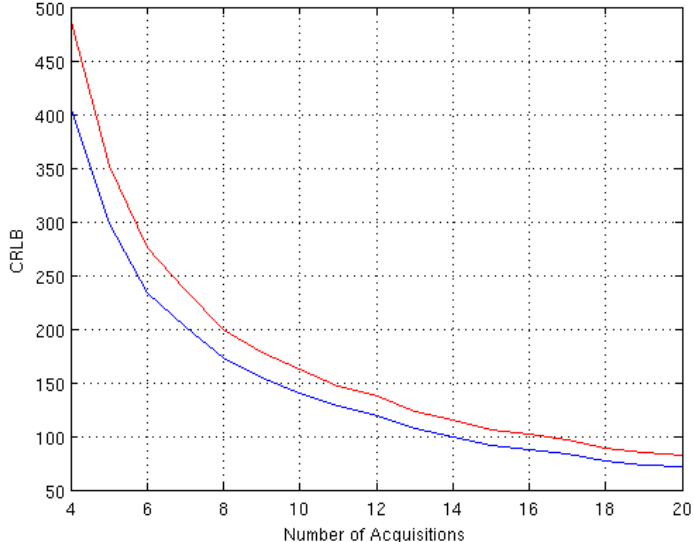
Figure 2. CRLB behavior in case of different number of acquisitions for the proposed Gaussian Complex Model (blue) and for the Rice Amplitude Model